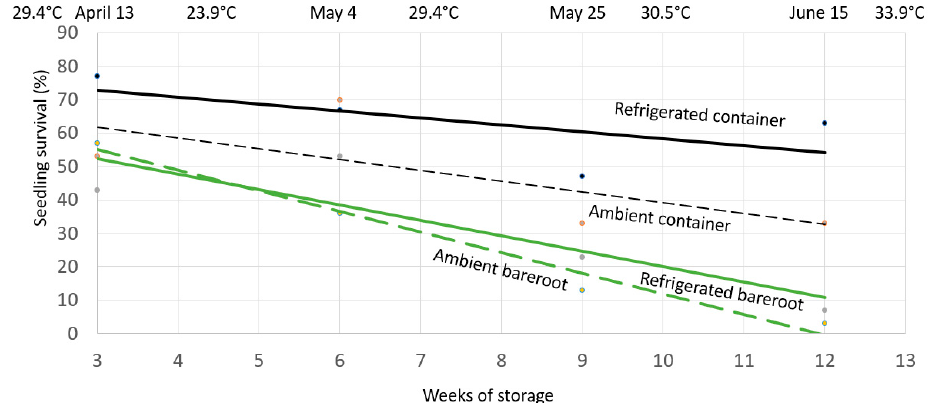
Figure 7. Effect of date of planting, storage length and storage method on survival of loblolly pine planted in Scott County, Tennessee [37]. The data presented assume 3 weeks of storage prior to plant- ing on April 13. Storing seedlings reduced survival, as did storing seedlings without refrigeration. The highest air temperature recorded for each 3-week period is indicated at the top of the graph. There were 30 seedlings planted per treatment-date combination. Bareroot seedlings, likely produced at Pinson, Tennessee, and container seedlings (likely Spencer-Lamaire root-trainers) were grown in a greenhouse at the University of Tennessee. The least significant difference is − 13.7% ( α = 0.05: one-tailed test). For ambient bareroot seedlings, p > |t| = 0.0057 for intercept and 0.012 for slope; R 2 = 0.97. The slopes of the remaining lines were not significantly different from zero ( p = 0.13 for refrigerated bareroot, 0.30 for ambient container and p = 0.36 for refrigerated